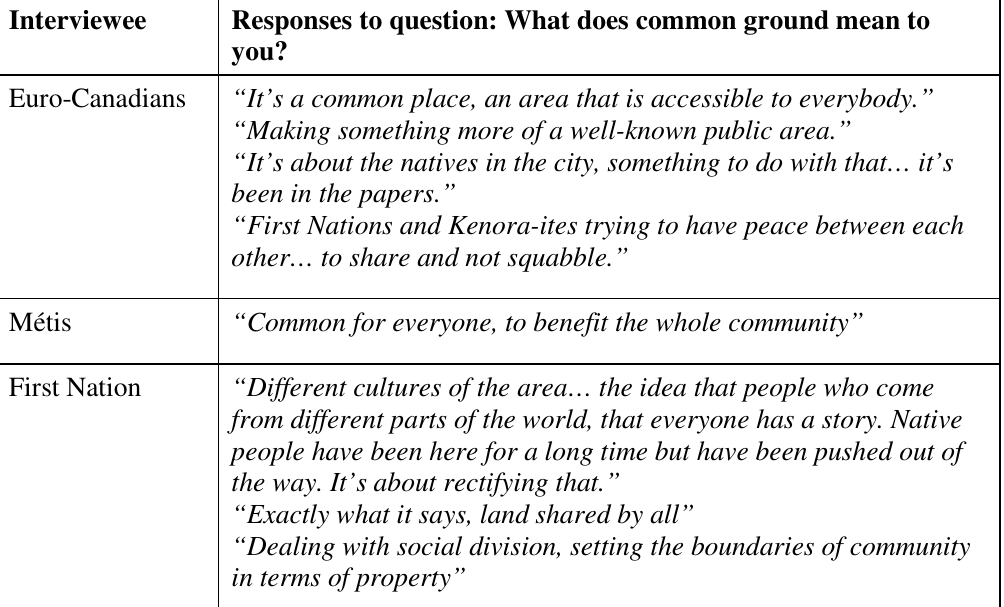
Table 1.3 – Understanding of ‘common ground’ among the general public